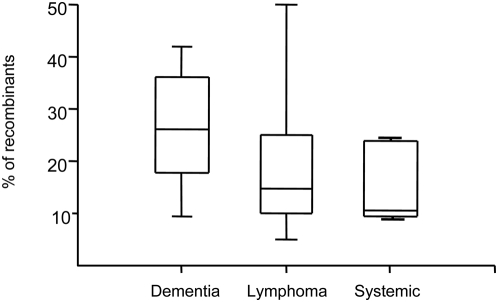
Distribution of HIV-1 recombinant sequences in subjects with different primary diseases.Each box plot shows the median, the 95-percentile distribution of the proportion of recombinants detected in tissues (y-axis) sampled from patients with different primary diseases (x-axis) and associated standard errors.